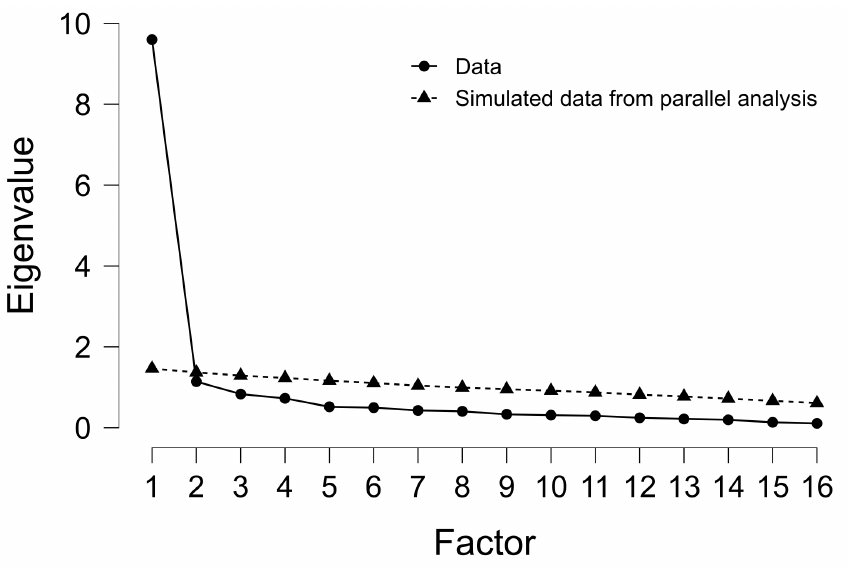
Figure 2. Scree plot showing the initial eigenvalues for exploratory factor analysis in Sample 1 and results of simulations on random data obtained in parallel